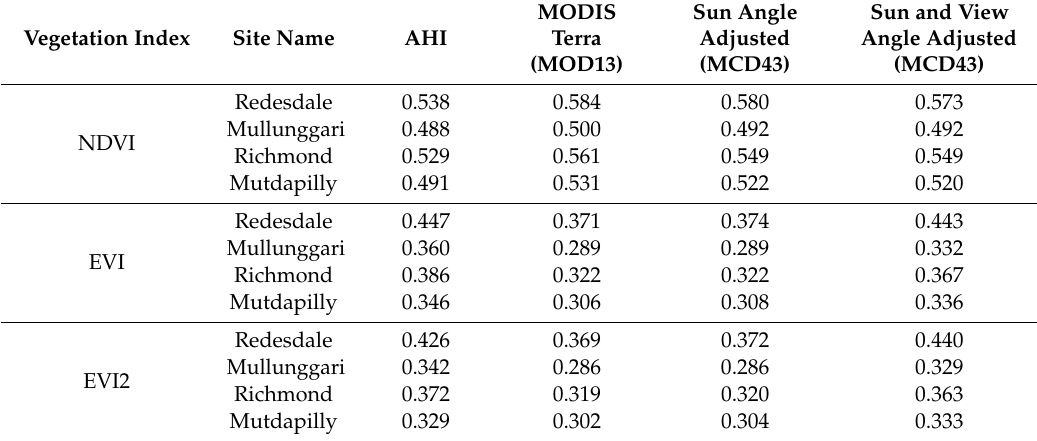
Table 3. Mean NDVI, EVI, and EVI2 values of Himawari-8 AHI and various MODIS products (MOD13 and MCD43) across the two growing